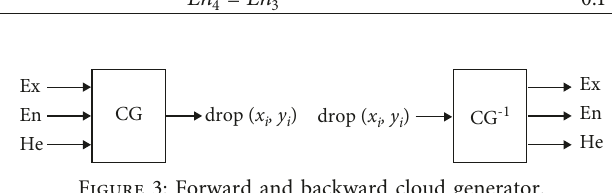
Figure 3: Forward and backward cloud